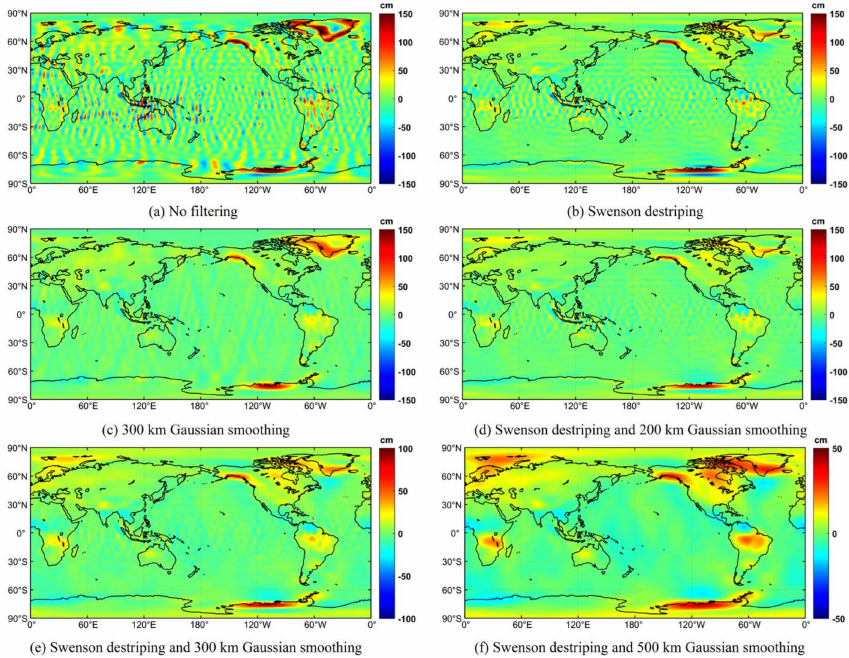
Figure 3. The spatial pattern of global TWSA obtained from GRACE in April 2002, with no filtering applied ( a ), only Swenson destriping applied ( b ), only 300 km Gaussian smoothing applied ( c ), and a combination of Swenson destriping and 200 km ( d ), 300 km ( e ), and 500 km ( f ) Gaussian smoothing